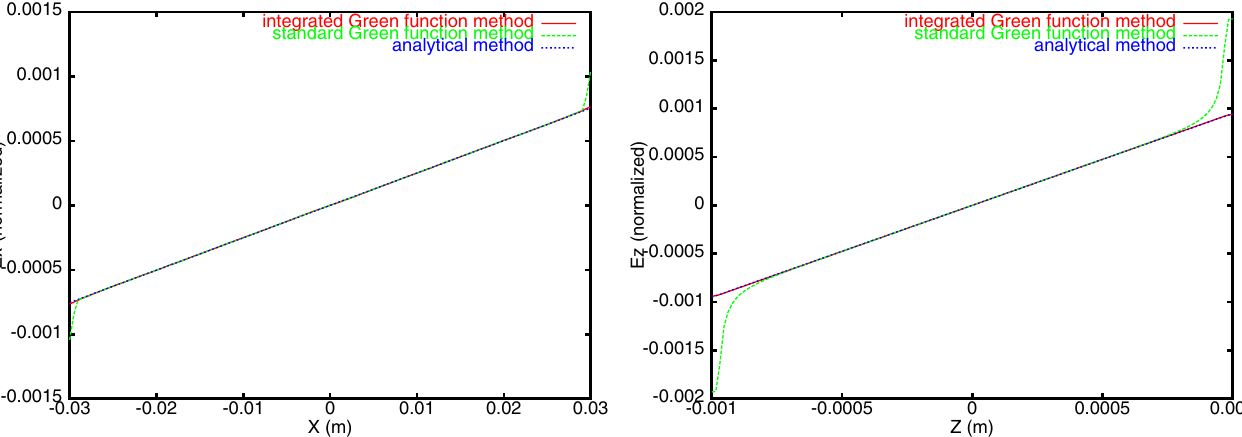
FIG. 5. (Color) Electric fields along x axis (left) and along z axis (right) of an uniform ellipsoidal beam with aspect ratio 30 from solutions of the integrated Green function method, the standard Green function method, and the analytical method.